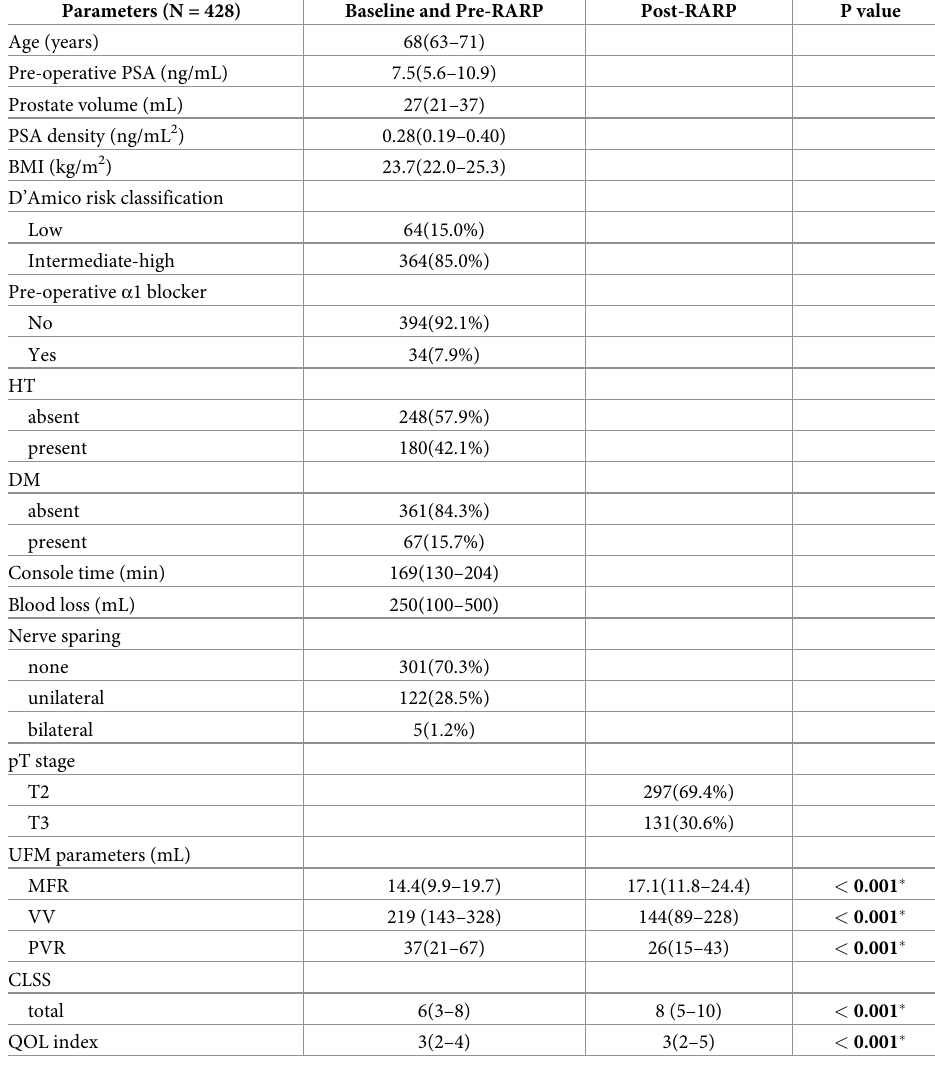
Table 1A. Comparison of pre- and post-RARP UFM parameters showed a significant increase in maximum flow rate (MFR), and significant decreases in voided volume (VV) and post-void residual urine (PVR). Median MFR increased from 14.4 to 17.1 mL/s, median VV decreased from 219 to 144 mL, and median PVR decreased from 37 to 26 mL (P values < 0.001 for all Table 1. Patient